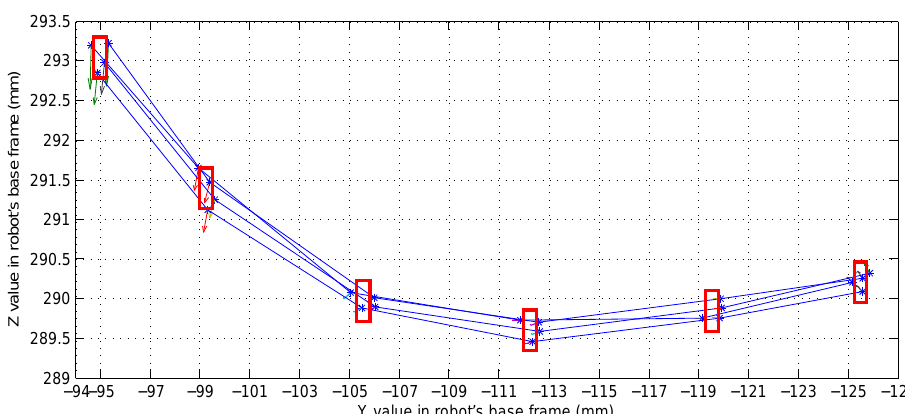
Figure 11. The projection of the paths shown in Figure 9 on the XZ plane.